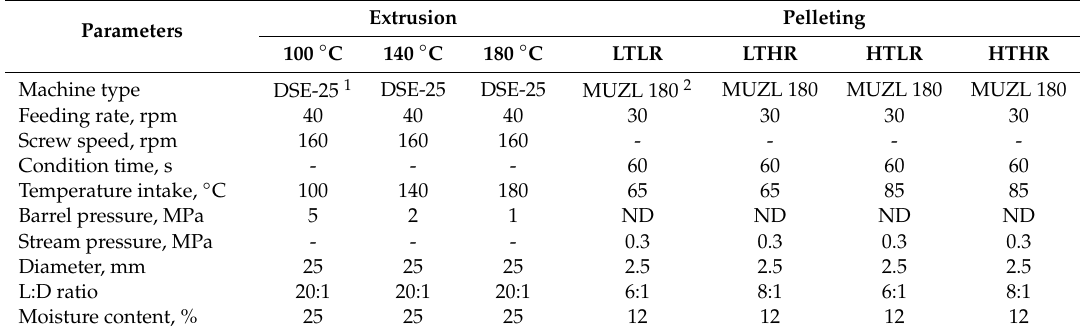
Table 2. Processing parameters of experimental